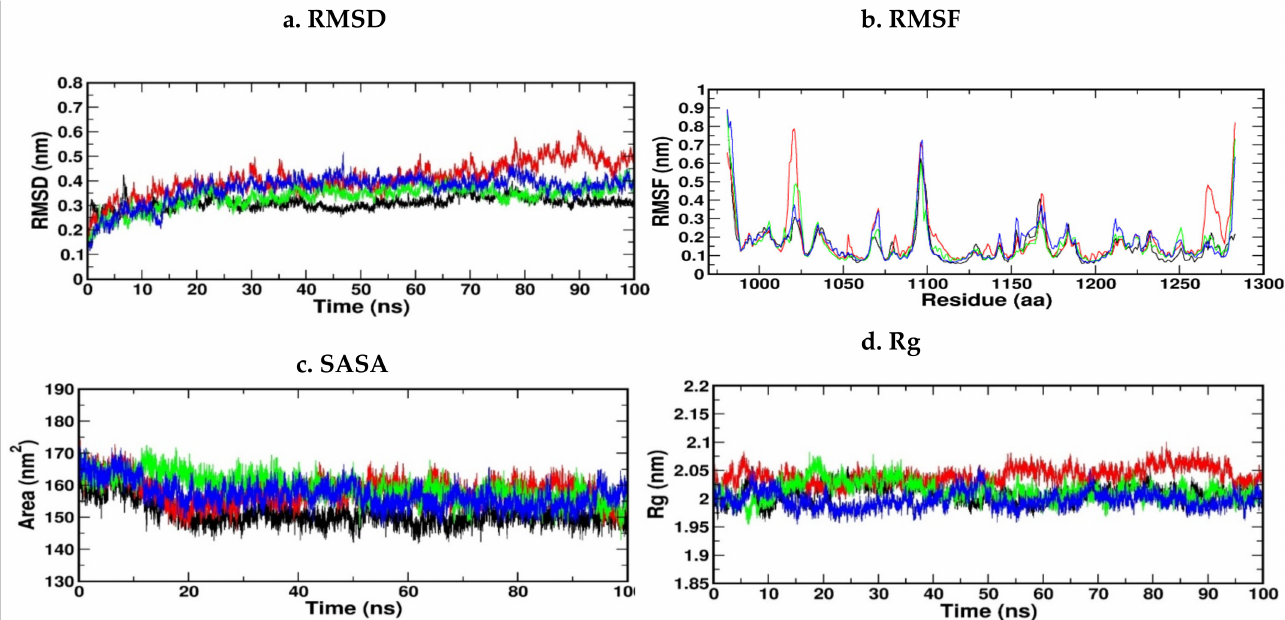
Figure 13. ( a – d ) RMSD, RMSF, SASA and RG of the IR protein with the top three compounds. Kaempferol shown in red, Quercitin (green), and Trans-Ferulic Acid